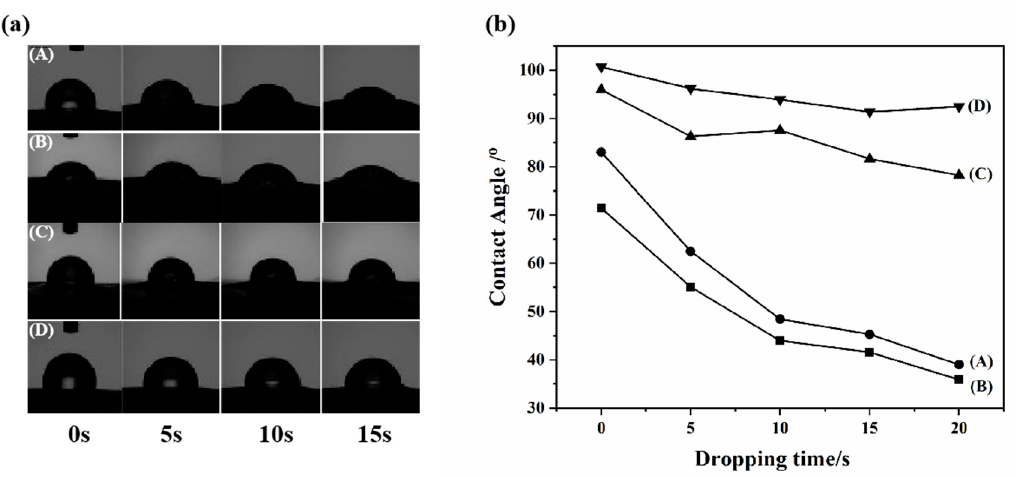
Figure 6. Water contact angle measurement for membranes. ( a ) Water droplets on membrane surface and ( b ) water contact angle with drop age (A: pristine S-SEBS; B: H302:S-SEBS = 0.15:1; C: H302:S-SEBS = 0.15:1 crosslinked at 100 °C; D: H302:S-SEBS = 0.15:1 crosslinked at 130 °C).